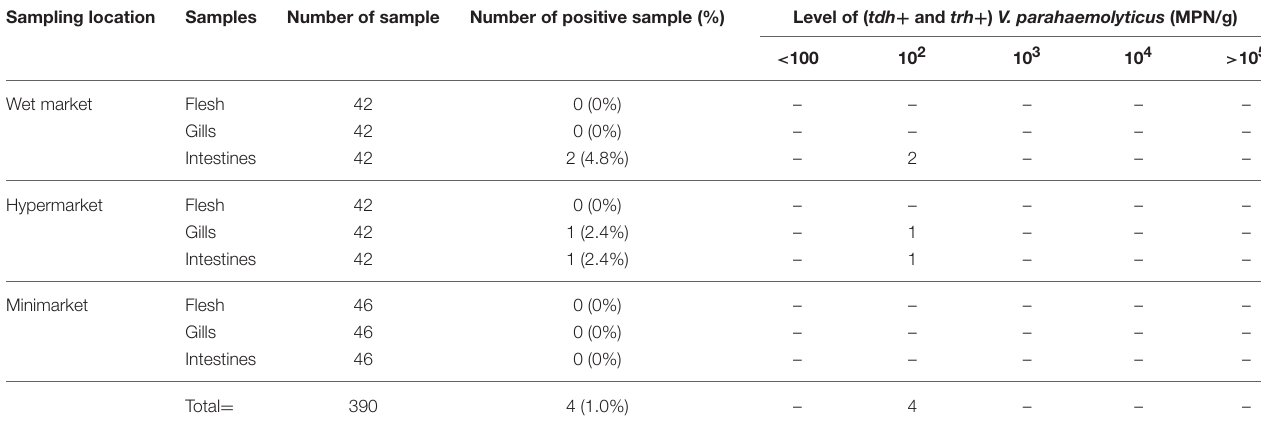
TABLE 3 | Prevalence and microbial loads of pathogenic tdh + and trh + V. parahaemolyticus strains in short mackerels. Sampling location